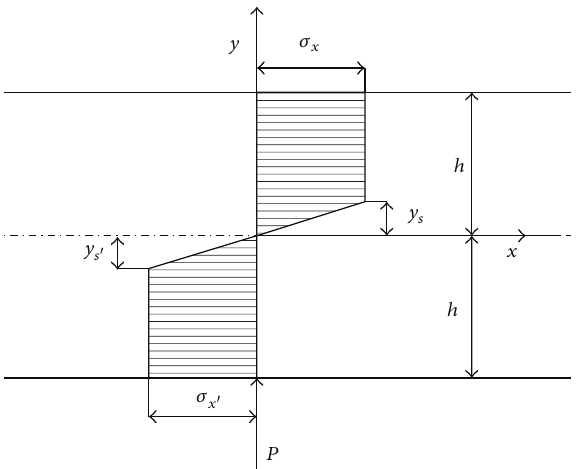
Figure 2: The new stress diagram in the cross section. 𝜏 = 𝜏 = 0 . Combining formula (2) with formula (3), 𝑧𝑥 𝑧𝑦 = 𝜎 𝜎 = (1/2)(𝜎 + 𝜎 ) , and 𝜎 = 0 can be obtained 𝜎 1 𝑥 , 2 1 3 3 where 𝜎 𝑥 = (2/√3)𝜎 𝑠